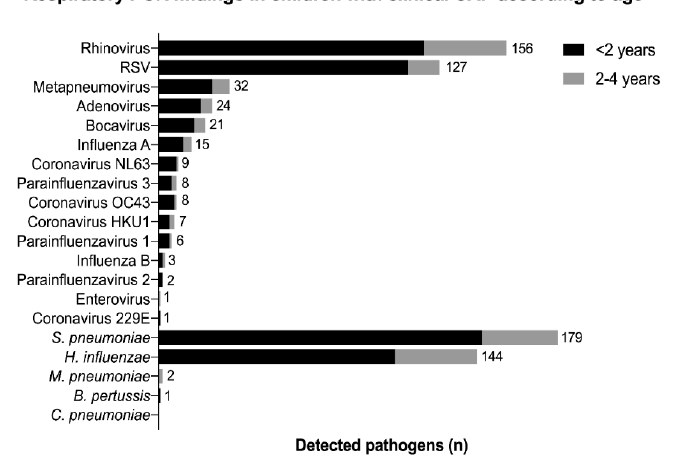
Figure 2. Real-time PCR findings according to age in nasopharyngeal aspirates of children with clinical CAP in the TREND study ( n = 327). Numbers showing the total number of detected pathogens. Abbreviations: B. pertussis , Bordetella pertussis ; C. pneumoniae , Chlamydophila pneumoniae ; CAP, community-acquired pneumonia; H. influenzae , Haemophilus influenzae ; M. pneumoniae , Mycoplasma pneumoniae ; PCR, polymerase chain reaction; RSV, respiratory syncytial virus; S. pneumoniae , Streptococcus pneumoniae ; TREND, Trial of Respiratory infections for Enhanced